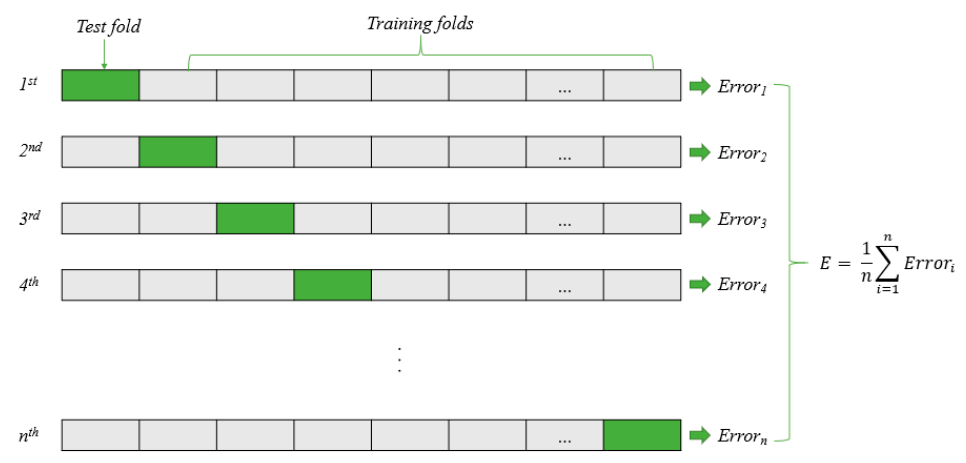
Figure 10. K-fold cross-validation.